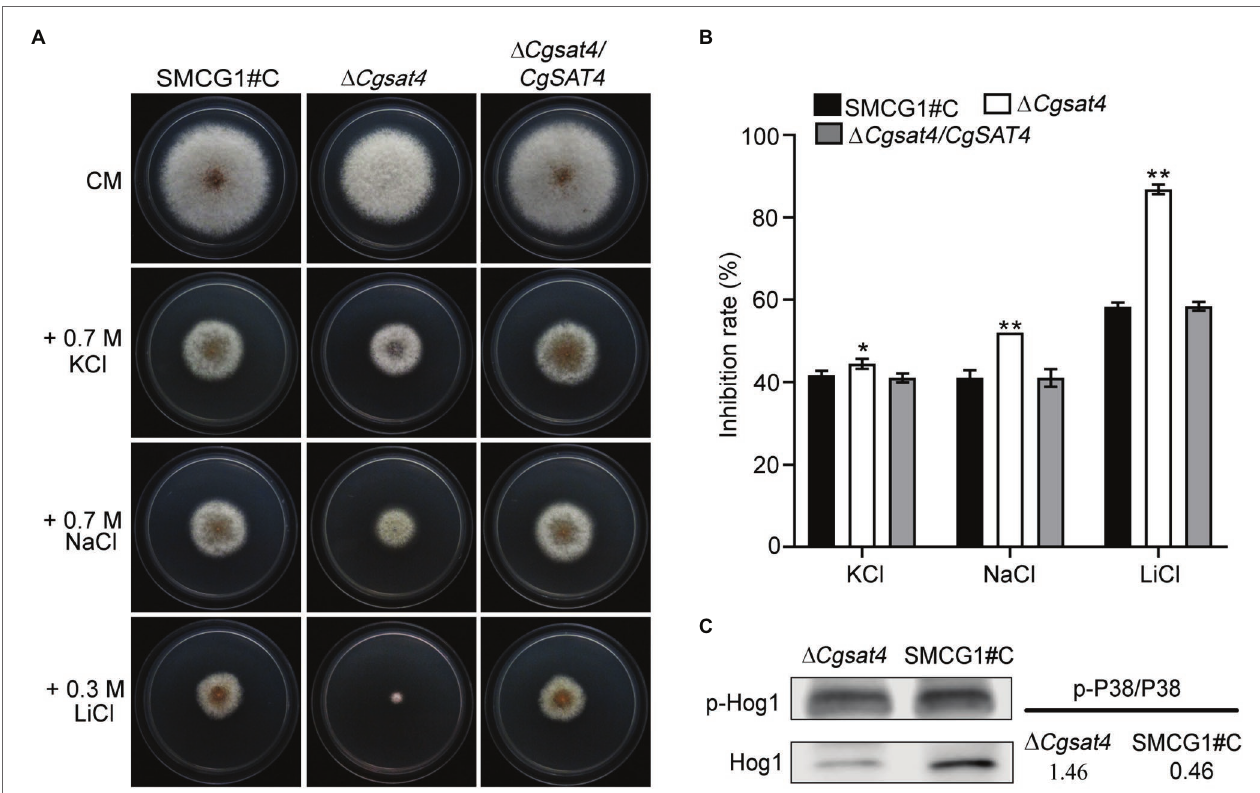
FIGURE 3 | CgSat4 required for extracellular cation stress resistance. (A) Colonies of the WT, ∆ Cgsat4 mutant, and the complemented strain ∆ Cgsat4/CgSAT4 cultured on CM medium supplemented with different cations for 4 days. n = 3. (B) Colony diameter inhibition rate in (A) . Error bars represent the SD. * and ** indicate significant difference at p < 0.05 and 0.01, respectively. n = 3. (C) Phosphorylation level of CgHog1 in the WT and ∆ Cgsat4 mutant was detected using an antiphospho-p38